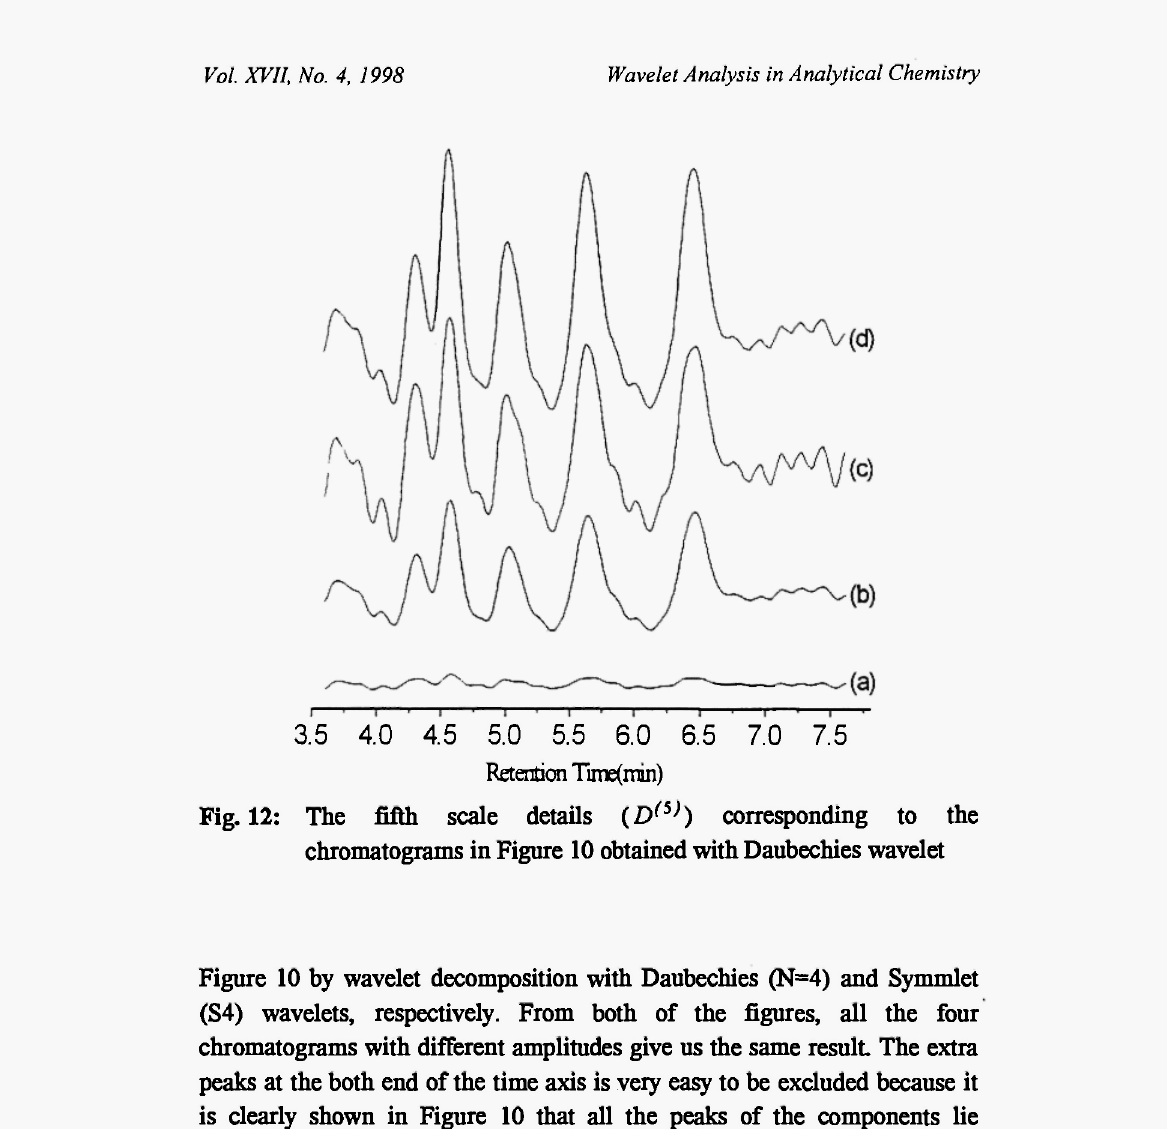
Figure 10 by wavelet decomposition with Daubechies (N=4) and Symmlet (S4) wavelets, respectively. From both of the figures, all the four chromatograms with different amplitudes give us the same result The extra peaks at the both end of the time axis is very easy to be excluded because it is clearly shown in Figure 10 that all the peaks of the components lie between